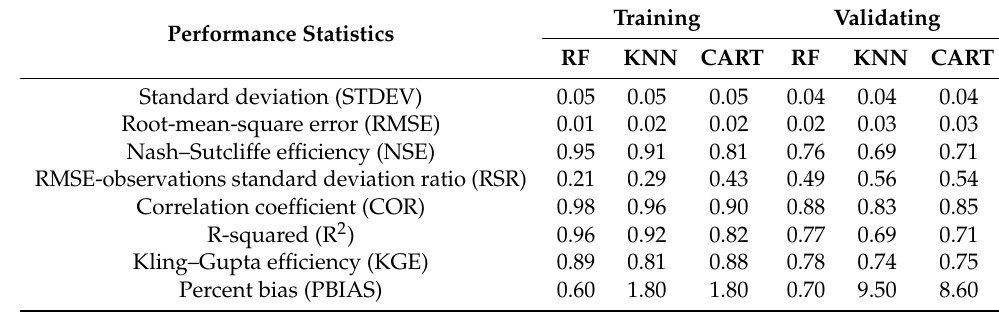
Table 3. Performance statistics of machine learning models (random forests (RF), k-nearest neighbors (KNN), and classification and regression trees (CART)) in land subsidence (LS) susceptibility